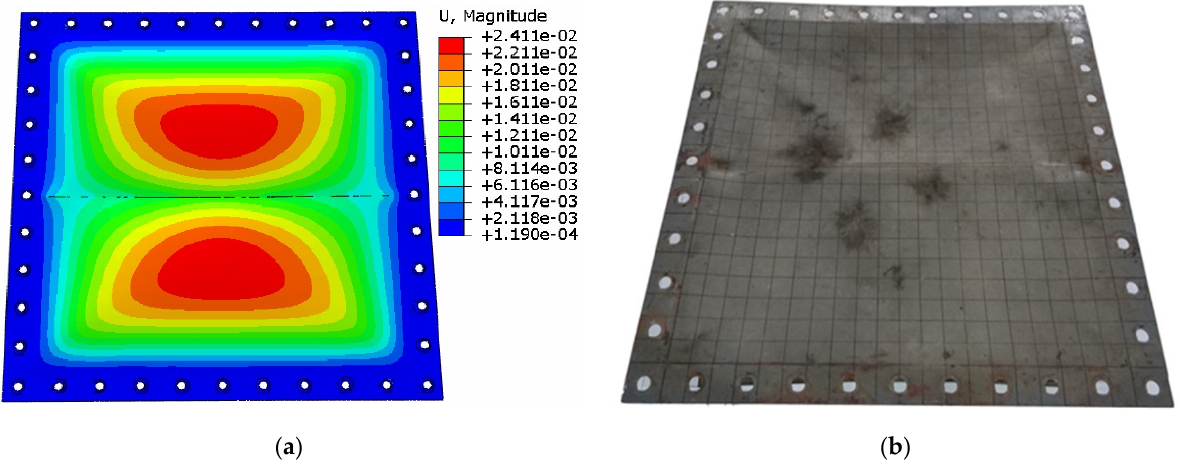
Figure 4. Comparison of plastic deformation for stiffened panel in simulation and test, reproduced from [37], with permission from Elsevier, 2021: ( a ) panel deformation from numerical simulation, and ( b ) panel deformation from test.